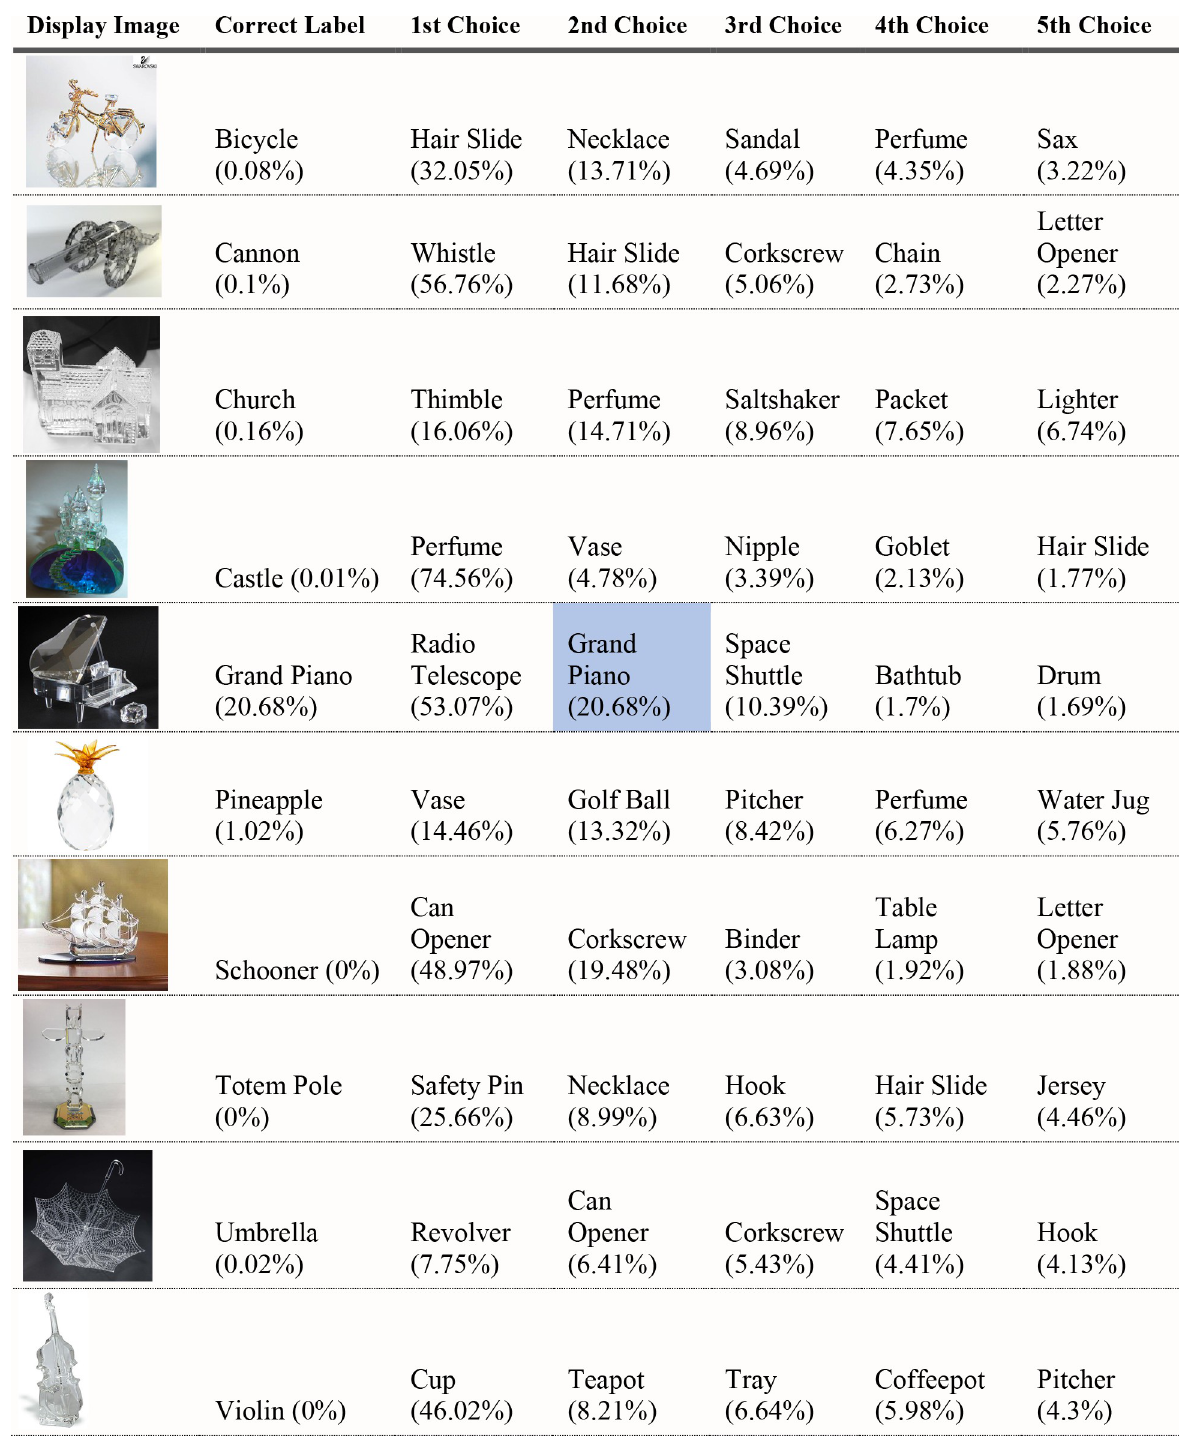
Fig 11. VGG-19 classifications for glass figurines Part 2.